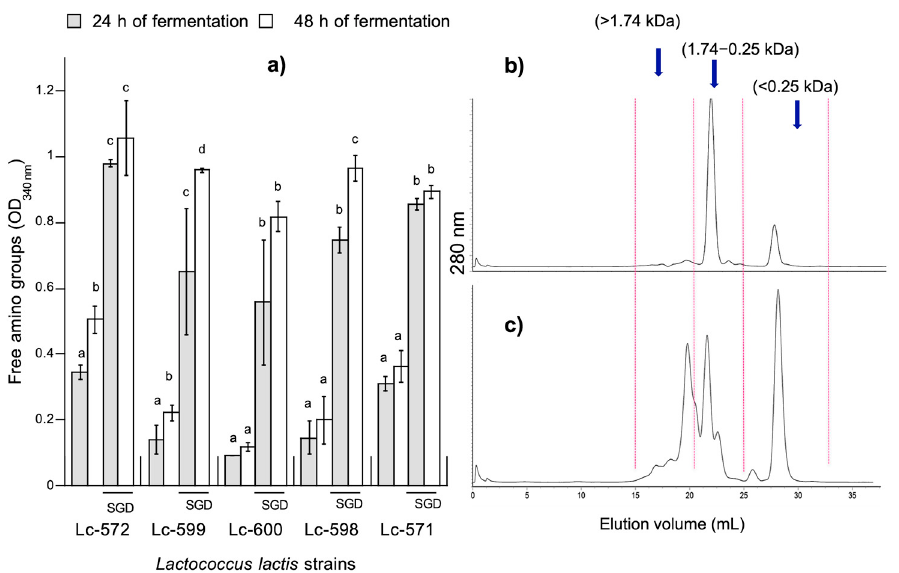
Figure 1. ( a ) Content of amino groups in fermented milk by Lactococcus lactis before and after simulated gastrointestinal digestion (SGD). Different letters (a – d) represent statistical differences ( p < 0.05) between fermentation times and before and after SGD for the same strain. Data are the average (± SD) of triplicate analysis. Typical peptide profile of water soluble fractions (WSF) before ( b ) and after ( c ) SGD of fermented milk with L. lactis , obtained by size exclusion chromatography.